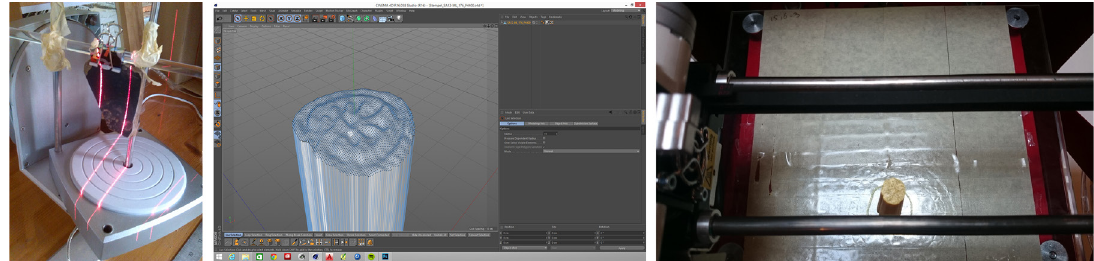
Figure 2. The reconstruction process of a stamp. Left: 3D scanning of a black gloss fragment with stamped decoration in Satri- cum . Center: 3D modelling of the stamp in Cinema4D. Right: the 3D print with the Builder of the stamp is ready. All photos by L.